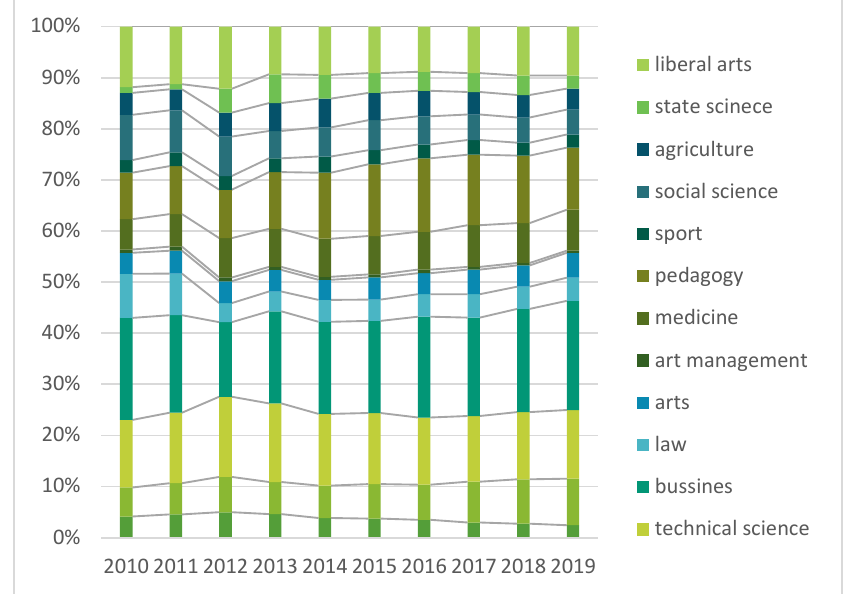
Fig. 1. The proportion of the first application rate in higher